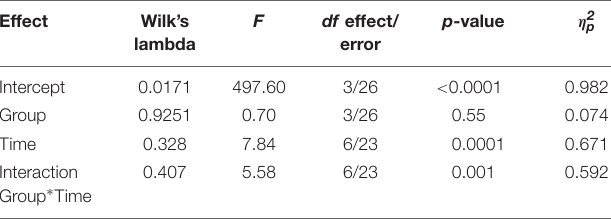
TABLE 3 | Multivariate model of RM ANOVA with the variables ‘highest pressure,’ ‘area,’ and ‘load’ for the right side of the pelvis region.